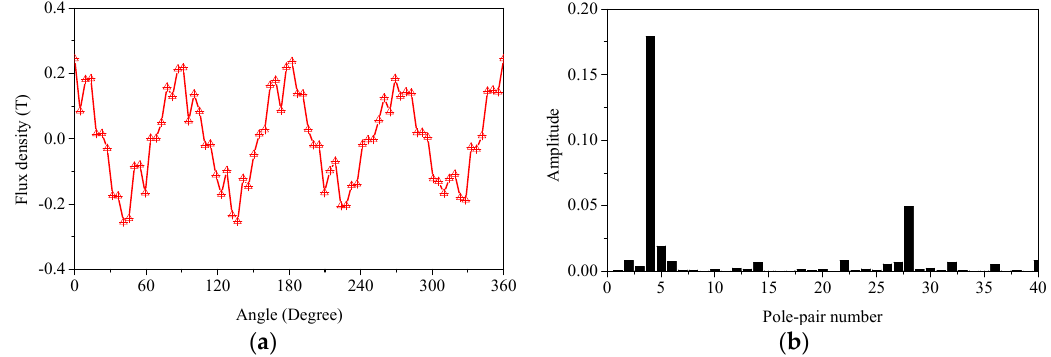
Figure 14. Airgap flux density in the inner airgap due to the outer rotor PMs: ( a ) flux density; and ( b ) harmonic spectrum.